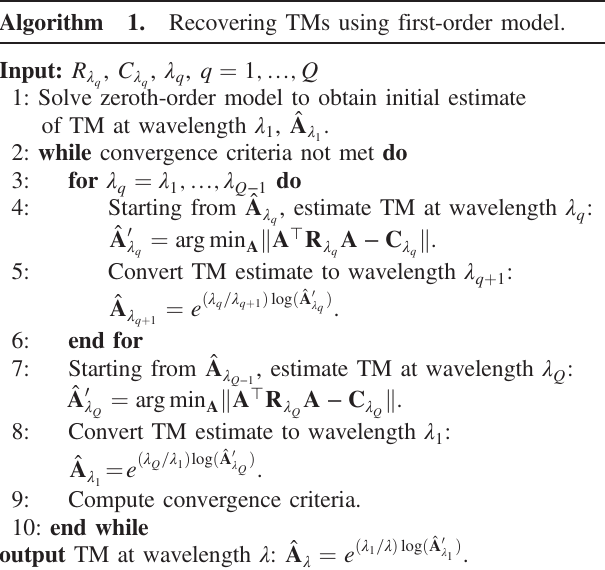
Algorithm 1. Recovering TMs using first-order model.